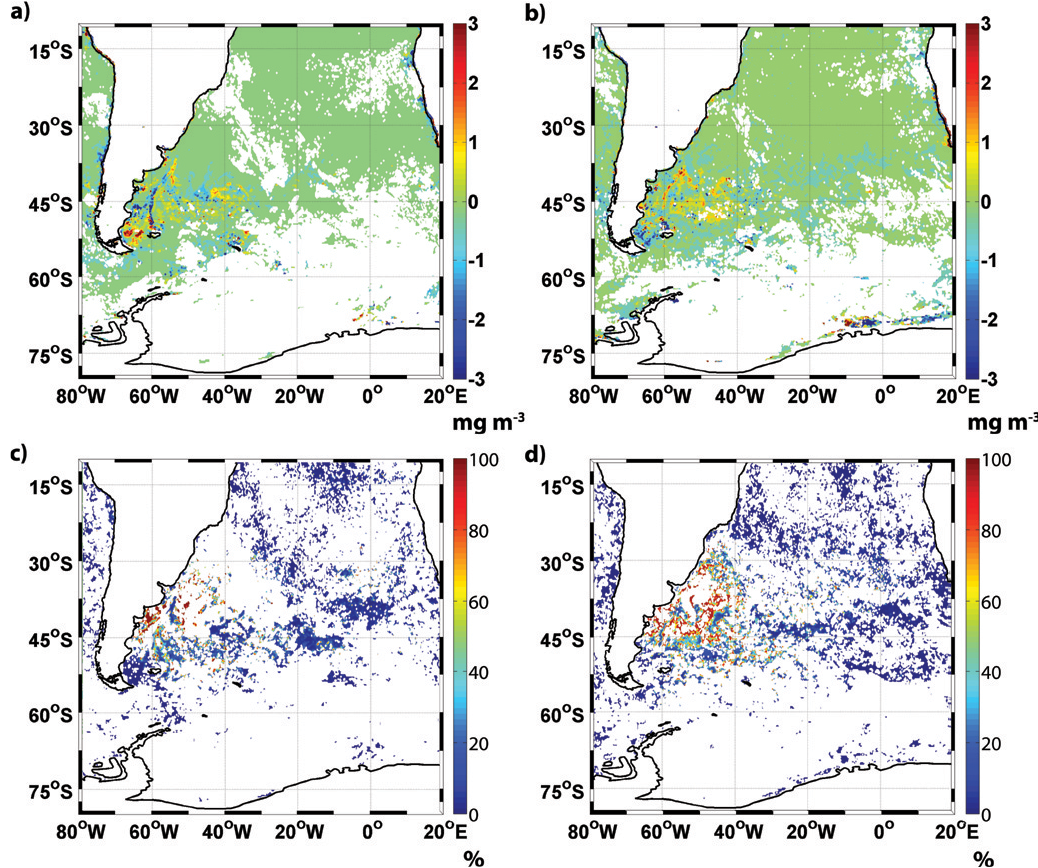
Fig. 9. Differences in SeaWiFS remotely-sensed 8-day averaged [Chl- a ] ( 1 [Chl- a ] obs ) (mgm − 3 ) and the percent ratio of 1 [Chl- a ] pred / 1 [Chl- a ] obs for the (a) , (c) J23 and (b) , (d) F11 dust episodes, respectively. The 1 [Chl- a ] obs for J23 and F11 episodes are